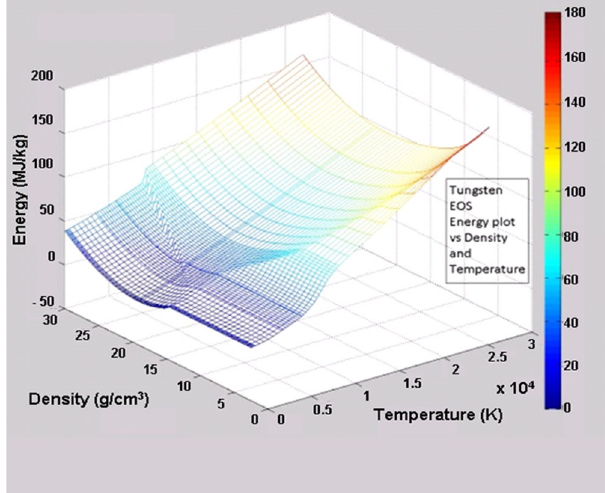
FIG. 25. A 3D plot of the SESAME (temperature vs density vs energy) used as the EOS for tungsten.